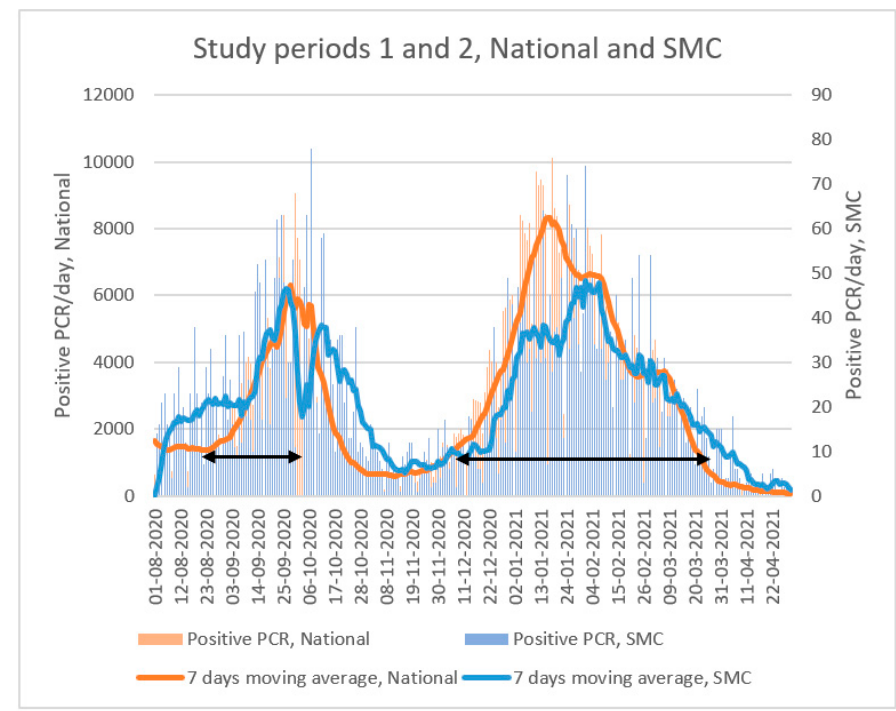
Figure 1. Daily detected SARS-CoV-2 cases in Israel and Sheba Medical Center during